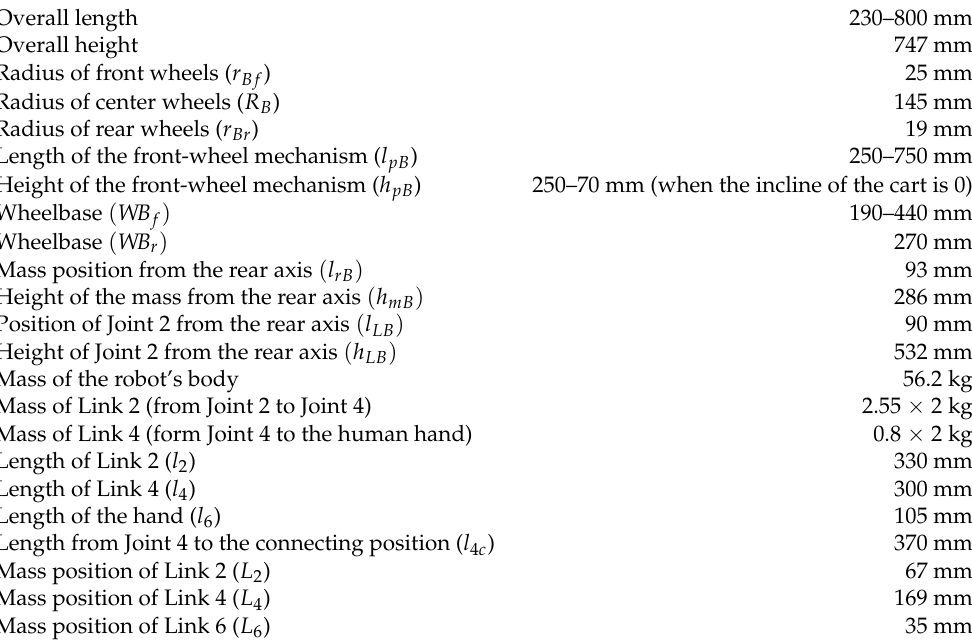
Table A1. Specifications of the robot.